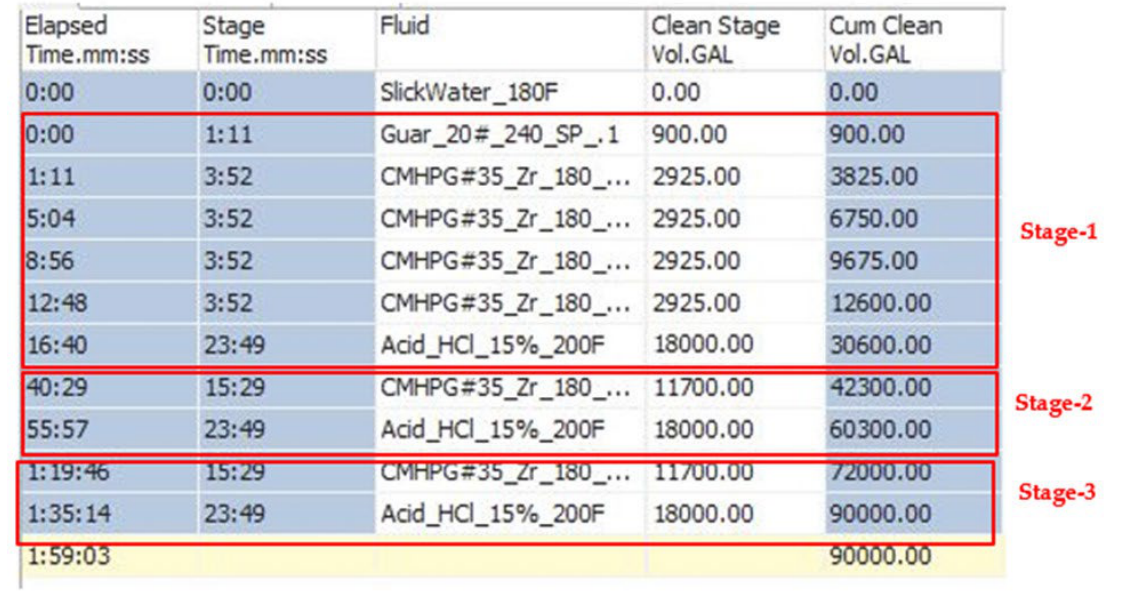
Figure 12. Final curves for the multistage fracturing scenario with optimized injection parameters (90 K-gal of fracturing fluid volume, 18 BPM injection rate, in three stages).